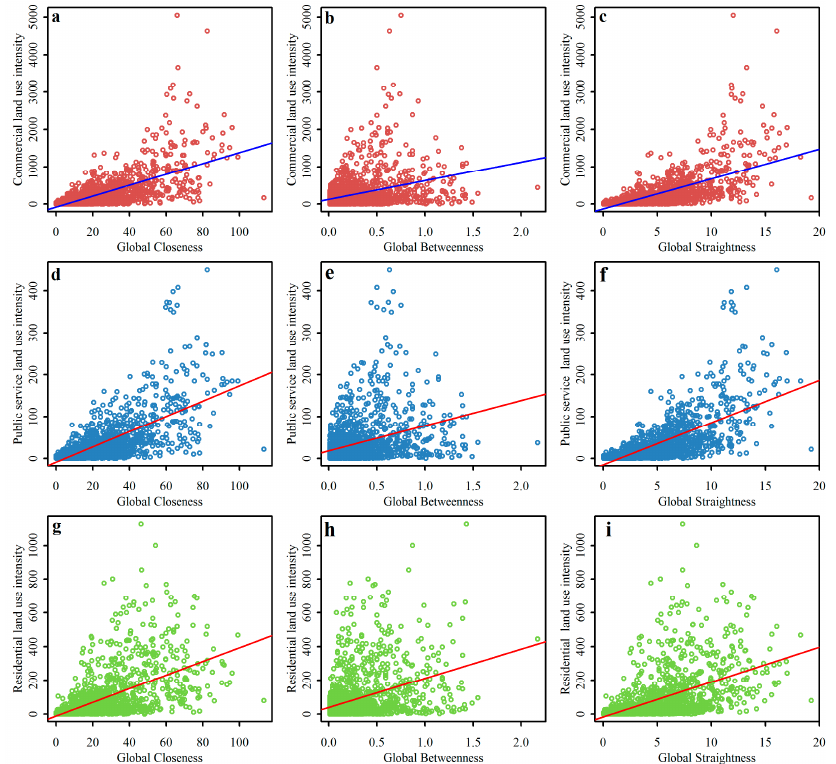
Figure 9. Scatter plots of street centralities and land use intensities. The same vertical column shares the same centrality indicator: Closeness, Betweenness, and Straightness, from left to right, respectively. The same horizontal row shares the same land use intensity: commercial land, public service land, and residential land, from top to bottom, respectively. The straight lines are linear regression lines.